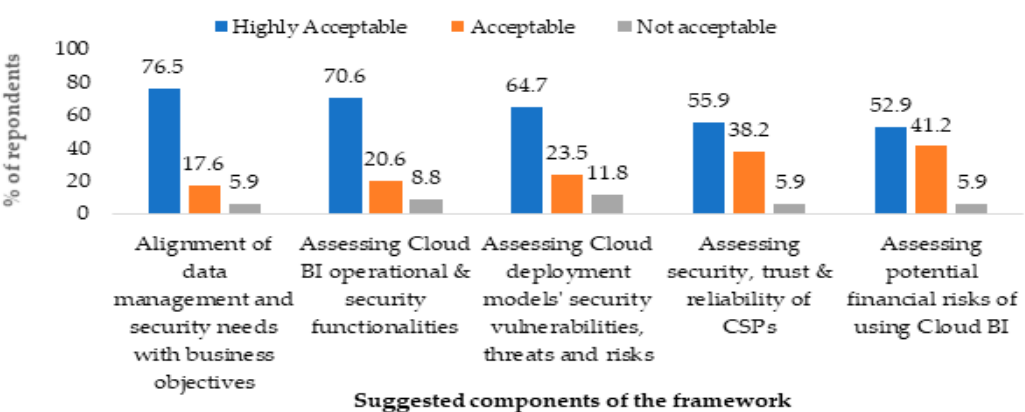
Figure 14. Acceptance validation results.